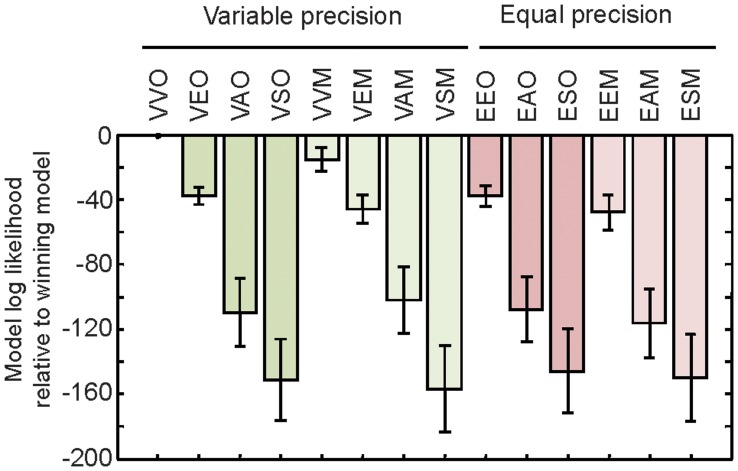
Log likelihood of each model relative to the VVO model.Negative values indicate that the model is less likely than the VVO model. Error bars represent s.e.m. Abbreviations and color scheme are as in Table 1.